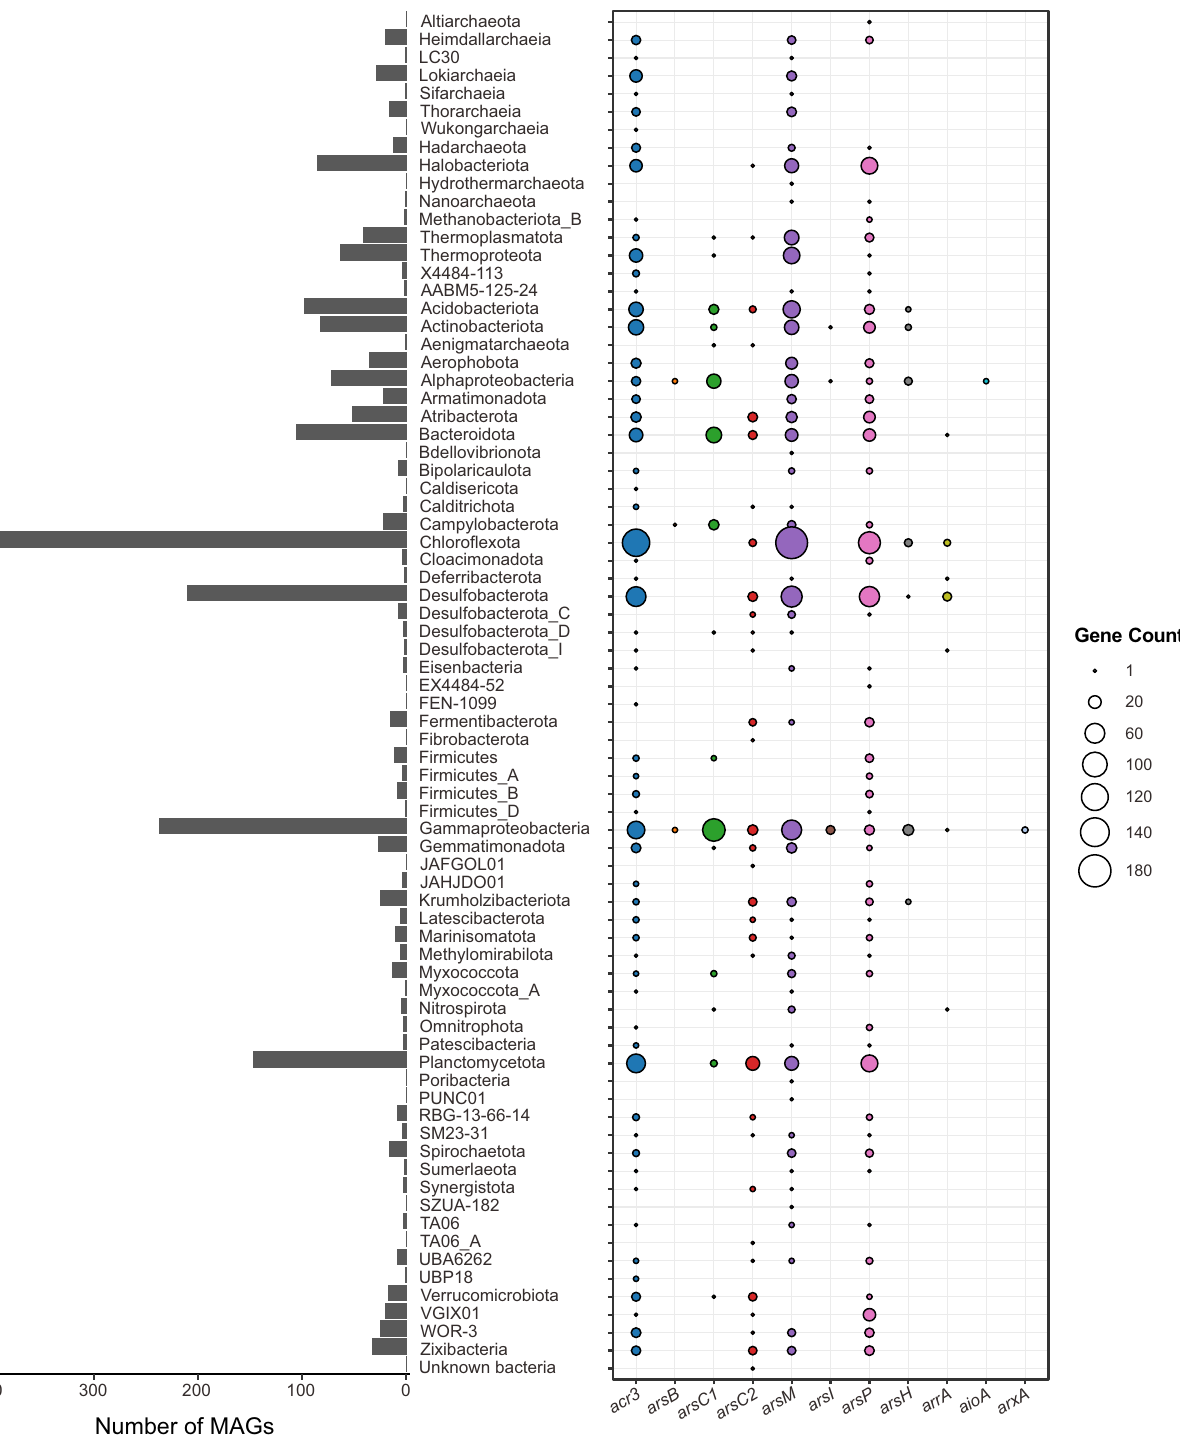
Fig. 4 Phylogenetic distribution of As-cycling genes. Left bar plot showing the total number of genomes encoded in each phylogenetic cluster assigned by GTDB-Tk based on GTDB r207 release. Right bubble plot showing the number of As-cycling genes encoded within each phylogenetic cluster. Detailed information on phylogenetic diversity of As-cycling genes is provided in Supplementary Data